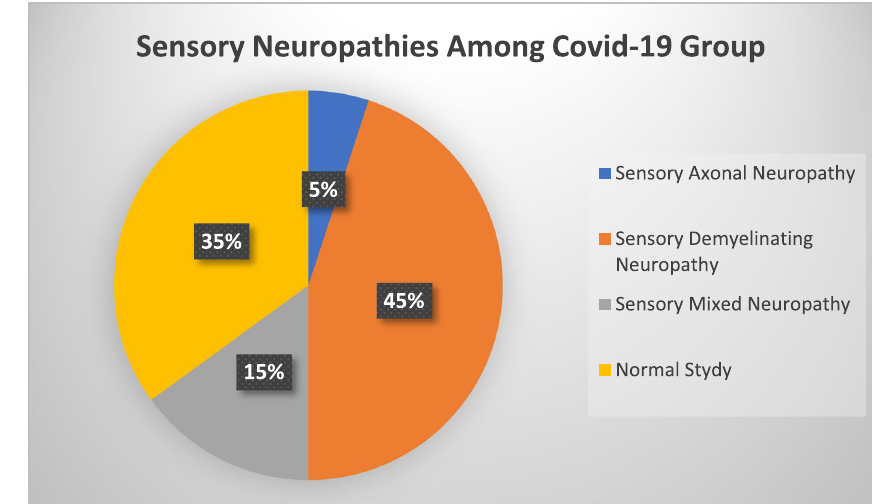
Fig. 2 Frequency and types of sensory neuropathies among COVID-19 groups ( n